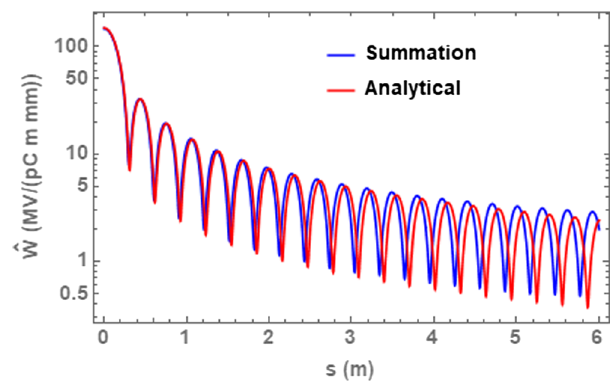
FIG. 24. A comparison of the transverse wakefields calculated via the summation method (25) and the analytical expression (28) for a linear tapered structure of θ ¼ 0 . 1 degrees and L ¼ 0 . 5